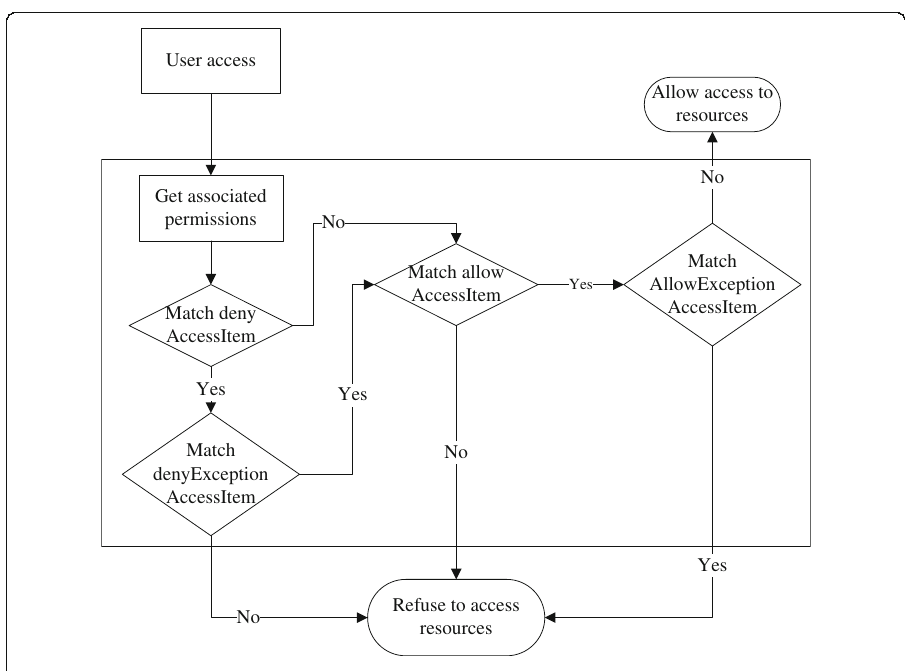
Fig. 2 The current policy-based access control